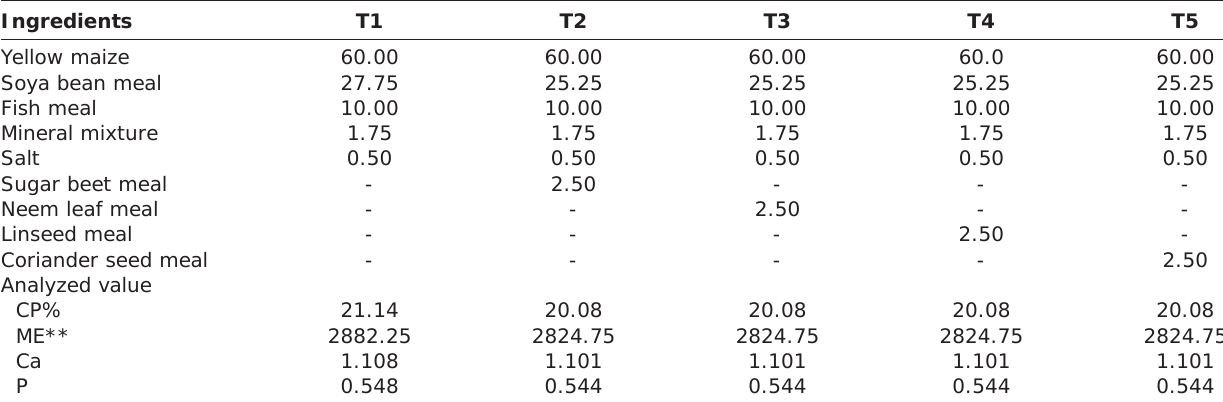
Table-4: Percentage chemical composition of experimental diet for finisher.